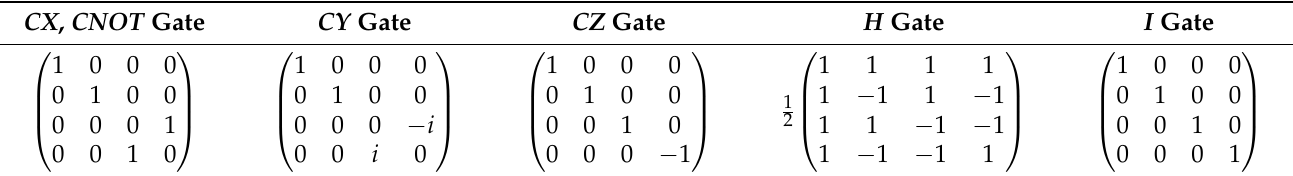
Table 5. Quantum gates for two